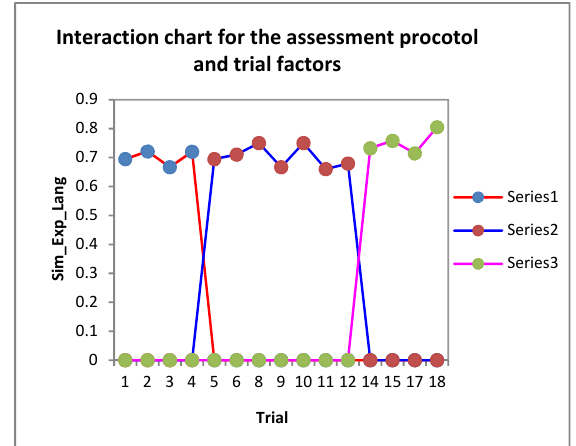
Figure 16. Relationship between SIM_Exp_Lang and the trial